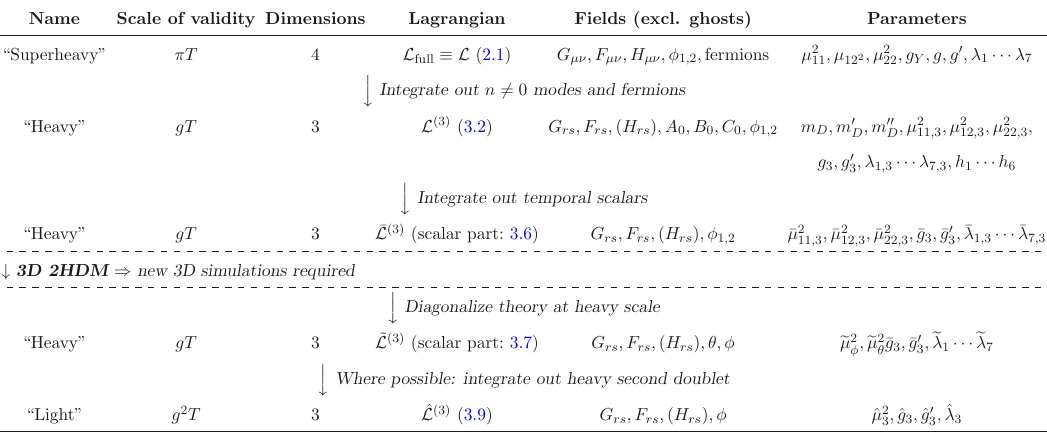
Table 1 . Dimensional reduction of the 2HDM into effective three-dimensional theories. Couplings of the effective theories are functions of the couplings of the full theory and are determined by the matching procedure. The last step is possible in the presence of a large µ 2 12 mixing